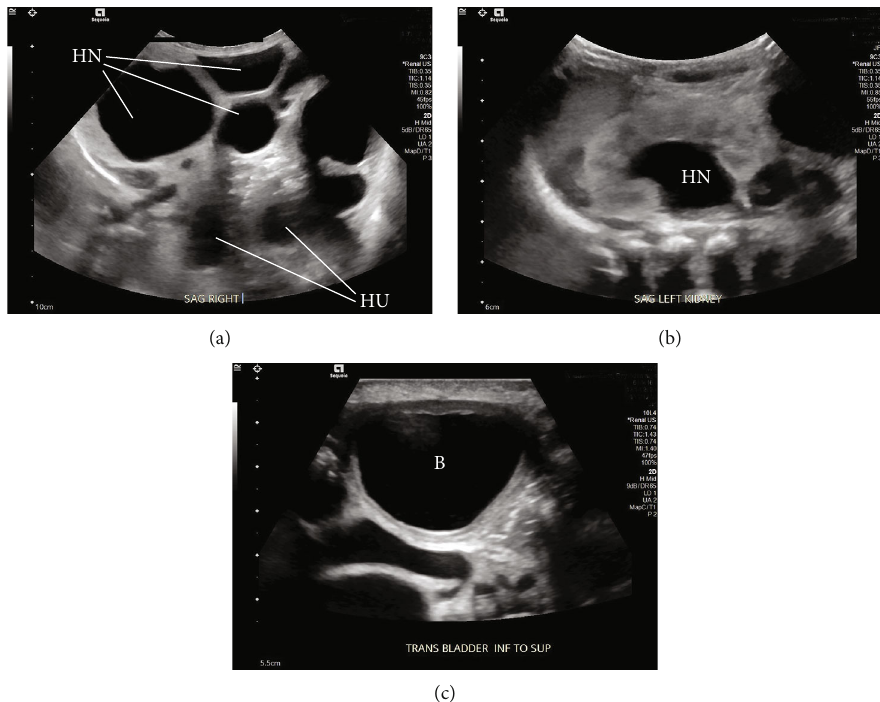
Figure 3: Renal and bladder sonography showed a severe (a) right hydroureteronephrosis, (b) moderate left hydroureteronephrosis, and (c) thick wall urinary bladder. HN: hydronephrosis; HU: hydroureter; B: urinary